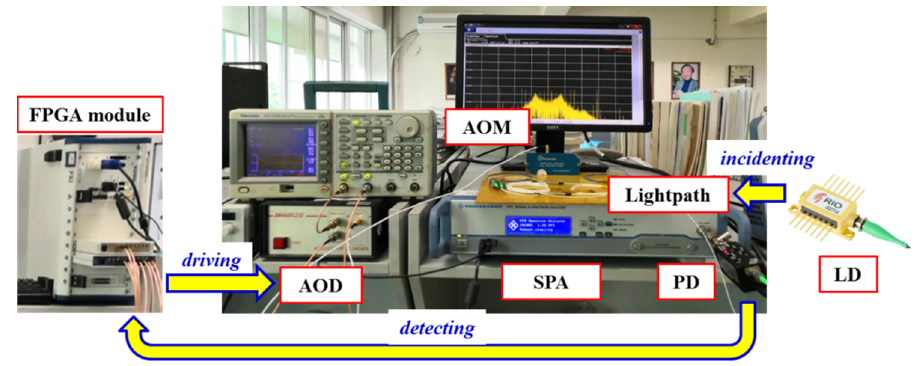
Figure 5. Structure of the test system for the low-noise multi-frequency laser (LNMFL) based on the HHD-OPLL.